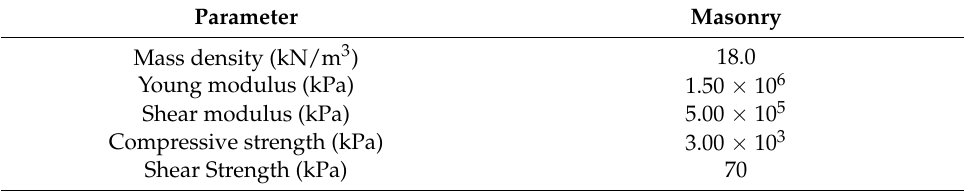
Table 4. Steel02 (Bars) characteristics.